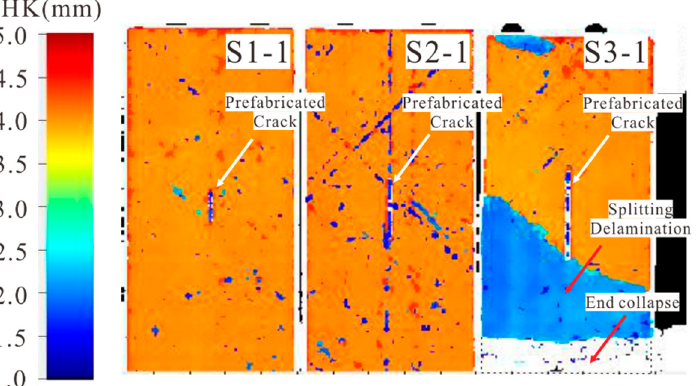
Figure 7. C-scan results of specimens with 0° shallow surface cracks. (THK represents the thickness from which the scanning ultrasonic wave gets reflected.)